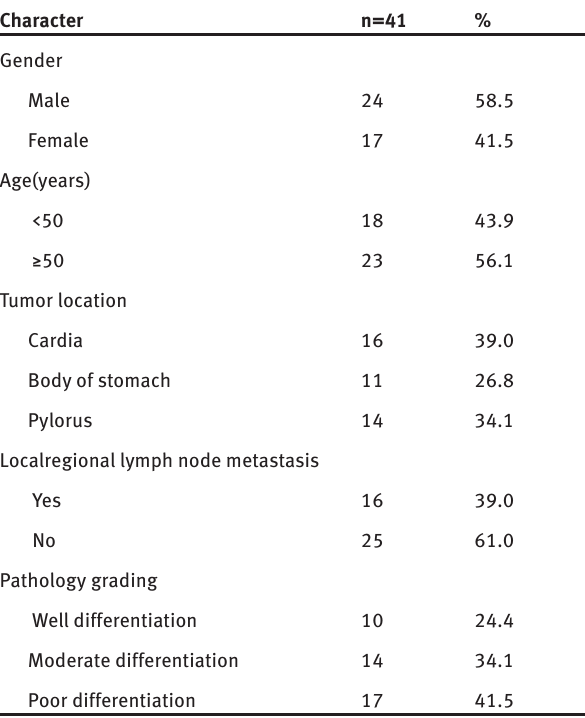
Table 1: The clinical character of the included 41 GC patients